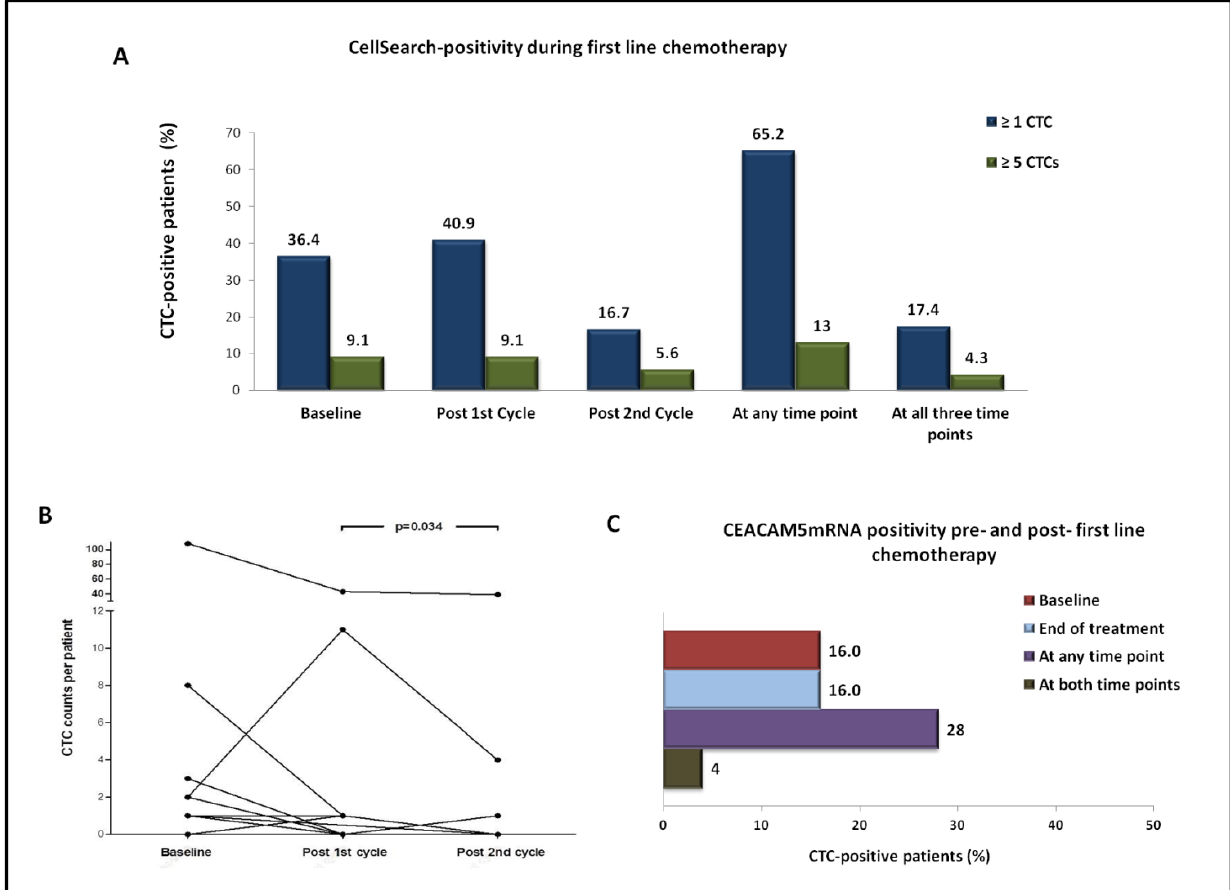
Figure 2. Kinetics of CTCs during first-line chemotherapy by using different detection approaches. ( A) Percentage of patients with detectable CTCs by CellSearch at different time points, using either ≥1 CTCs or ≥5 CTCs as a threshold for positivity. ( B) Per patient distribution of CTCs detected using CellSearch at different time points. ( C) Percentage of patients with detectable CTCs using the CEACAM5 mRNA assay at the start and end of treatment .